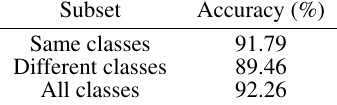
Table 4. Classification accuracies on UCM when different subsets of MLRSNet are used for training the feature